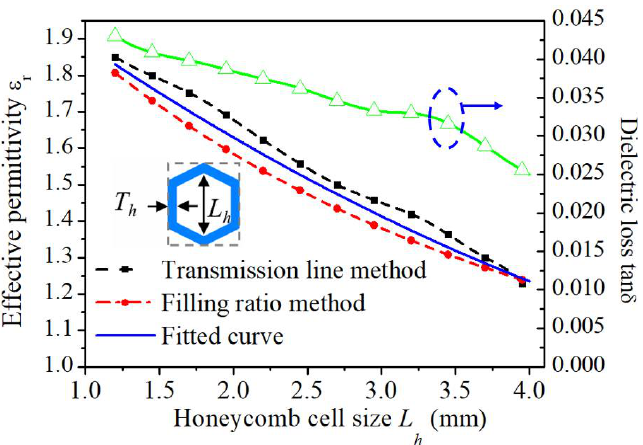
Figure 2. Effective permittivity (left axis) and dielectric loss (right axis) of honeycomb cell versus different size of honeycomb cells L h .